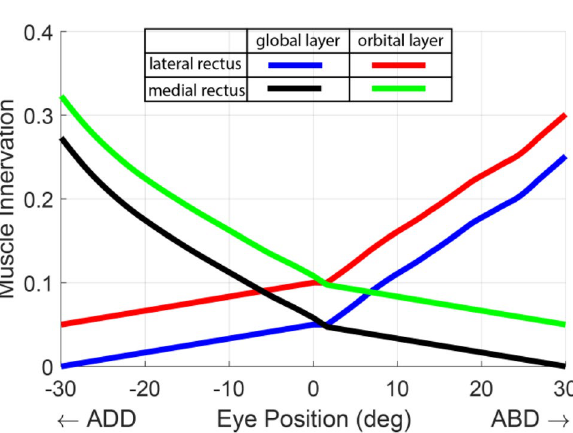
Figure 2. Innervations of lateral and medial rectus muscles at different horizontal eye positions during simulated fixation. Innervation is a unitless scalar between 0 and